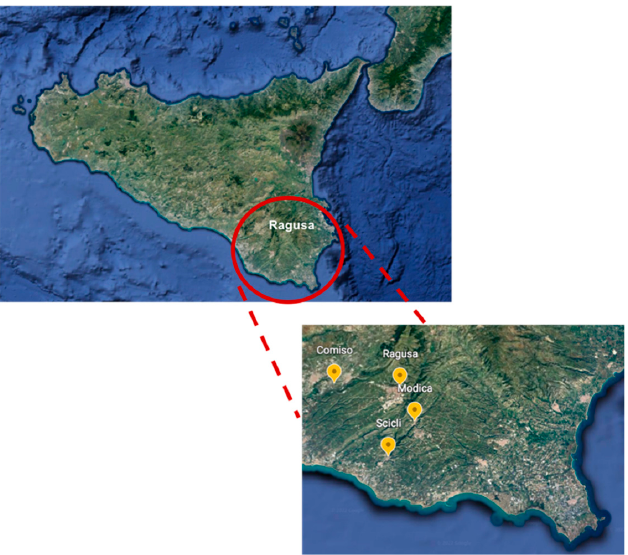
Figure 1. Sample collection area. Samples were collected in four municipalities of Ragusa province (Ragusa, Comiso, Modica and Scicli).